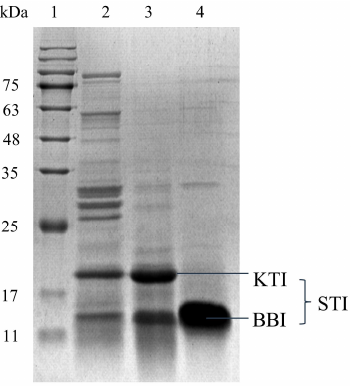
Figure 1. The electrophoretic pattern of the soybean whey protein. Lane 1 represents the marker, whereas lanes 2, 3, and 4 denote the soybean whey, KTI (Sigma), and BBI (Sigma), respectively.